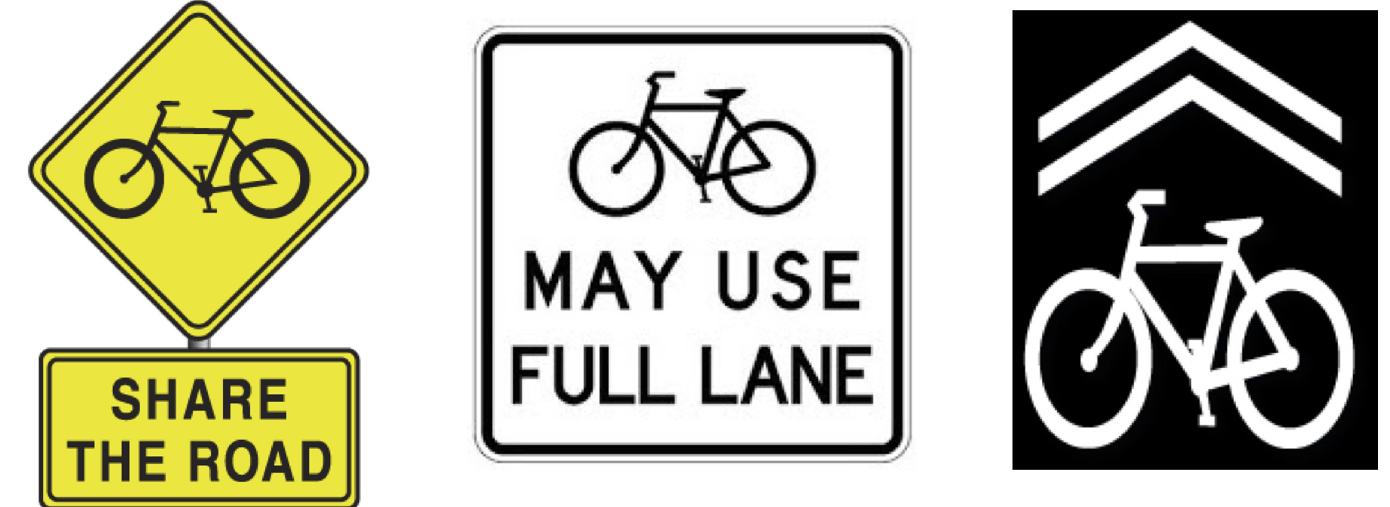
Fig 2. Bicycle-related traffic control devices. From left to right, “ Share the Road ” (Manual on Uniform Traffic Control Devices W11-1 upper plaque plus W16-1 lower) and “ Bicycles May Use Full Lane ” (R4-11) signage; Shared Lane Markings (sharrows) are painted on the roadway pavement